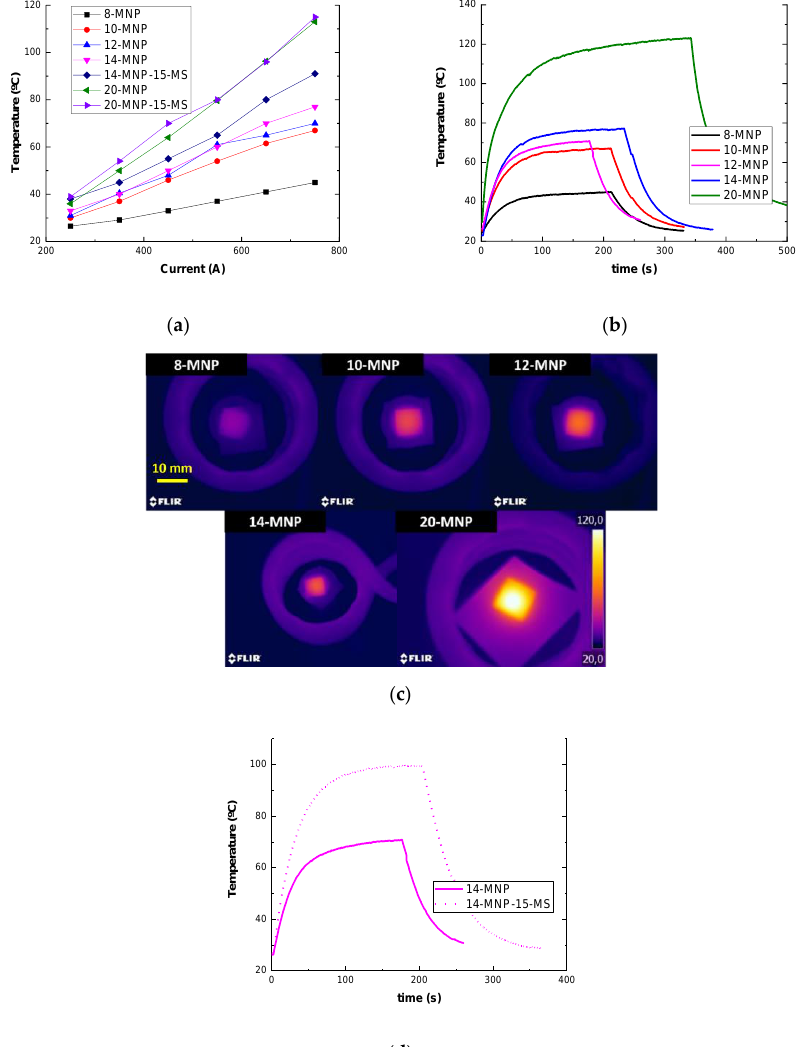
Figure 5. ( a ) Temperature reached for each condition as a function of the inductive current applied, ( b ) heating – cooling curves of EM heating as a function of the MNP content, ( c ) IR images at the stabilization phase, and ( d ) heating – cooling curves of the 14 wt.% MNP samples with and without MS inclusion.